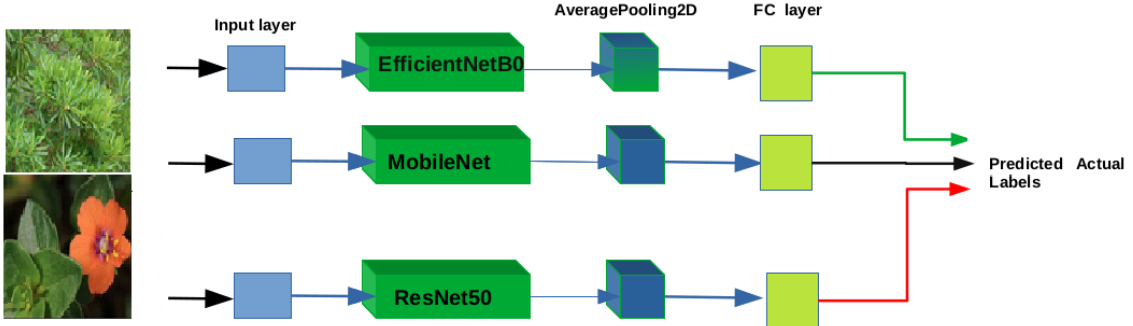
Figure 2. Estimating the type of plants with the CNN